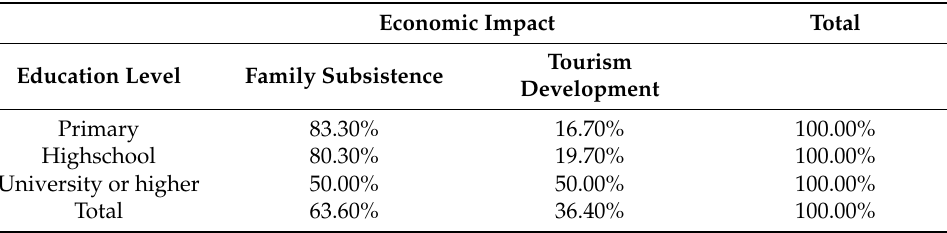
Table 6. Crosstabulation between economic impact and education